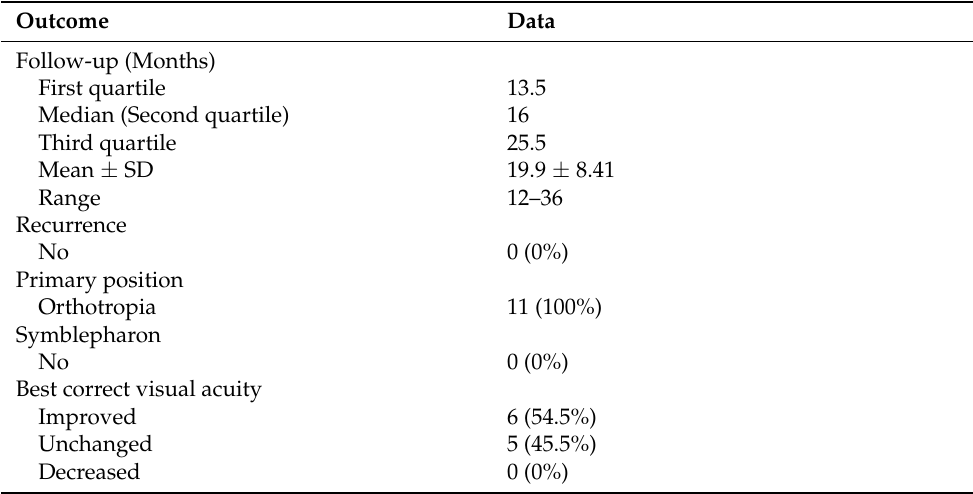
Table 2. Recurrent pterygium with restrictive strabismus underwent sandwich transplantation: post-operation